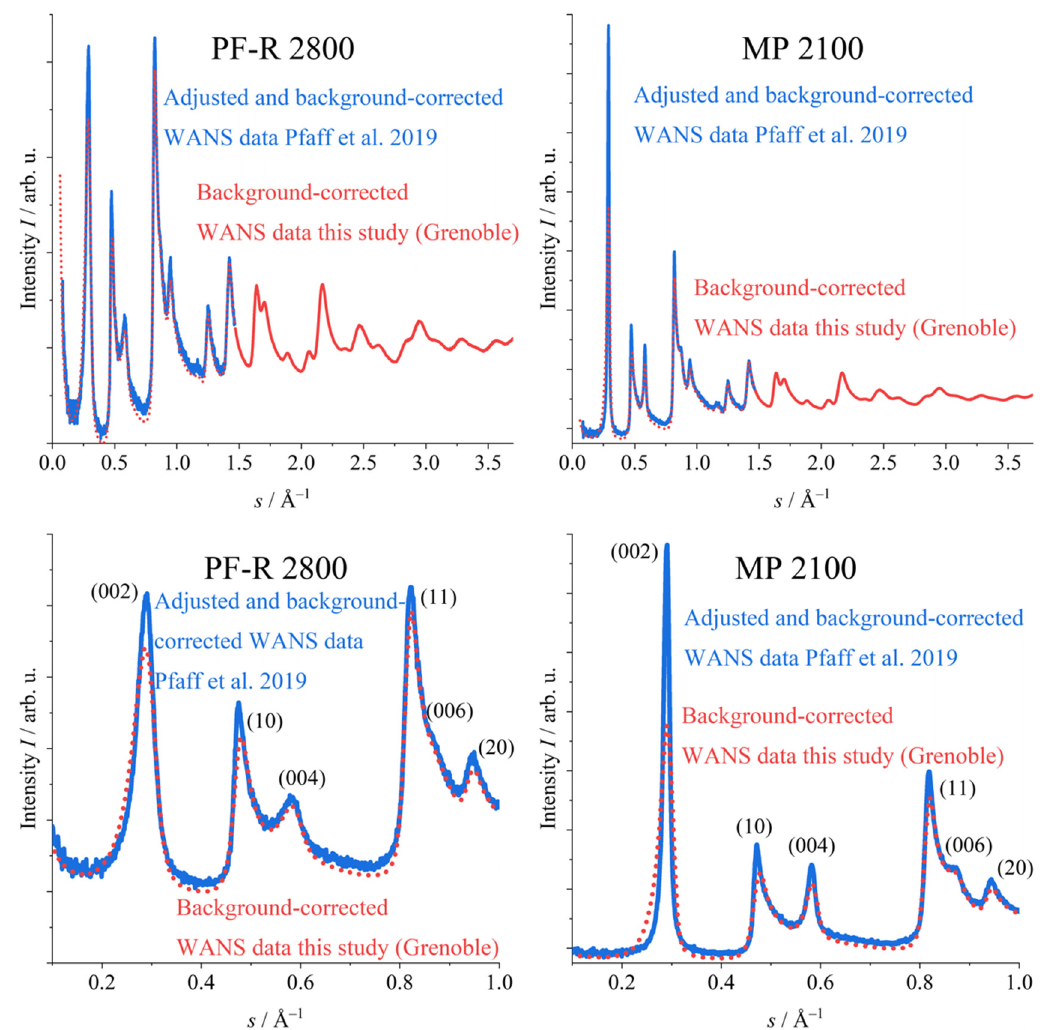
Figure 4. The WANS data from Pfaff et al. (2019) [43] (blue) were combined with WANS data from this study (red). In the range of lower s -values, the WANS data from this study (red dotted) were only slightly different for PF-R 2800 (disordered glass-like carbon). For MP 2100 (graphitizable mesophase pitch), the differences were more pronounced, since this sample was more ordered and showed sharper reflections. In addition, the s -space resolution of the WANS data acquired at the Grenoble facility was lower than that of Pfaff et al. As a result, the reflections in the anterior s -region were broader and had lower intensity. Overall, by combining the different WANS data, both the interlayer and intralayer parameters could be accurately determined.